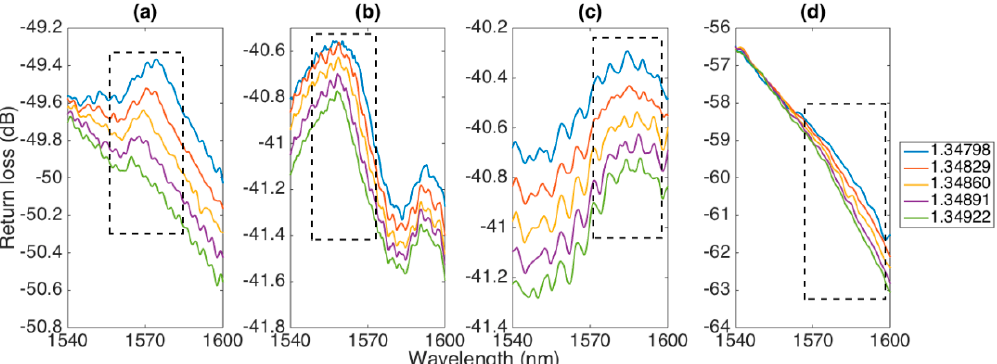
Figure 5. Reflection spectra of the different ball resonators, reporting return loss in the 1540 – 1600 nm range for different RI values (1.34798 – 1.34922). The window in each chart shows the spectral feature interrogated by the system. Ball resonator diameters: ( a ) 547 µm; ( b ) 532 µm; ( c ) 494 µm; ( d ) 466 µm.